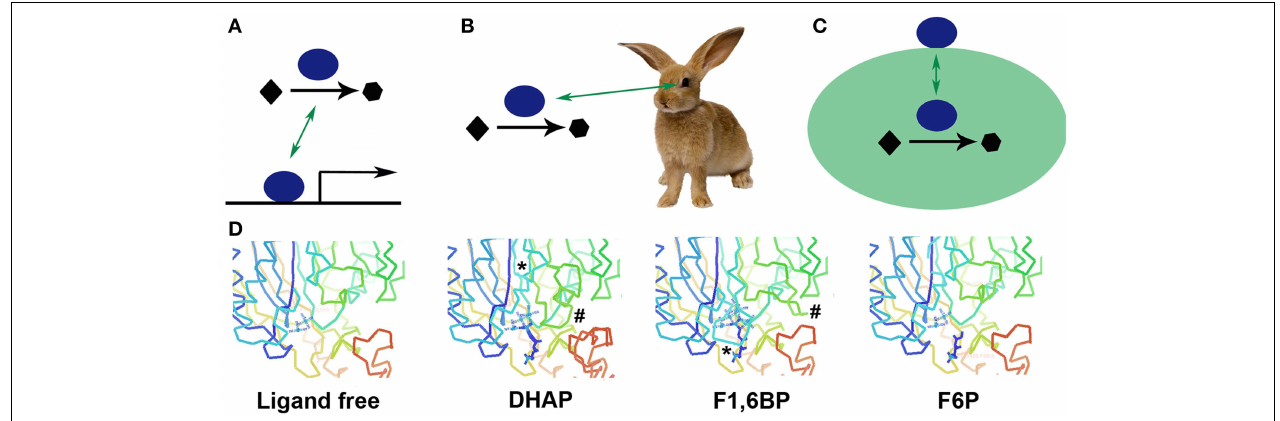
FIGURE 1 | Cartoons illustrating how a protein can moonlight. A protein can catalyze an enzymatic reaction and also (A) bind to DNA and serve as a transcription factor, (B) have a noncatalytic role in the lens of the eye (crystallins), or (C) be placed on the surface of a cell to function as a receptor. Another type of moonlighting is illustrated in